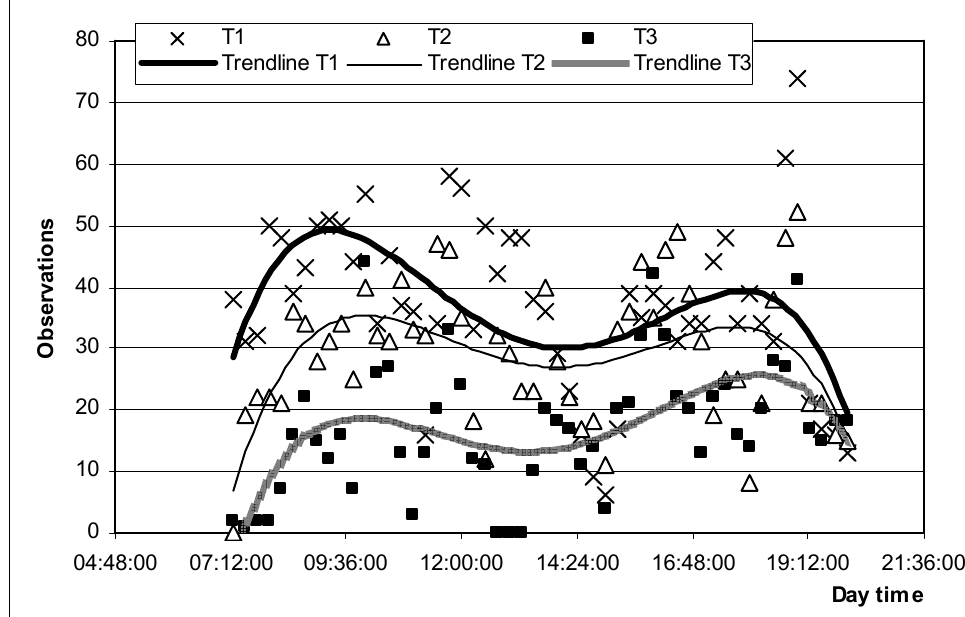
Figure 8. Daytime grazing frequency and distribution by treatment.